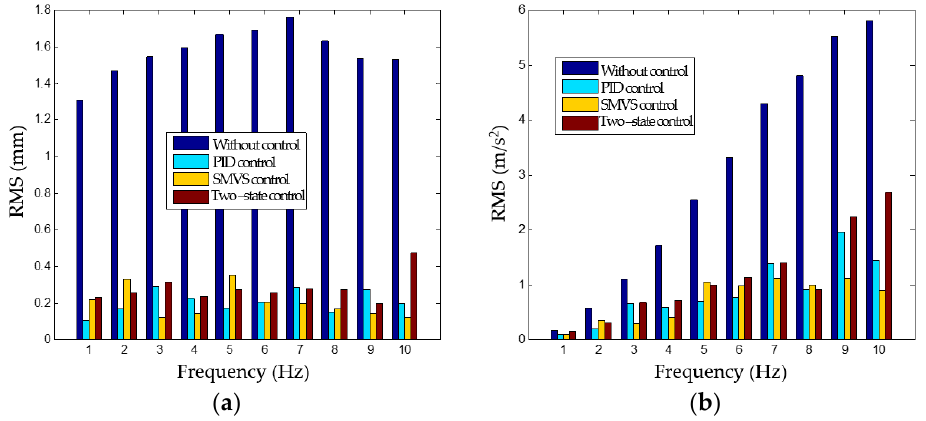
Figure 17. RMS of displacement and acceleration: (a) Displacement; (b) Acceleration